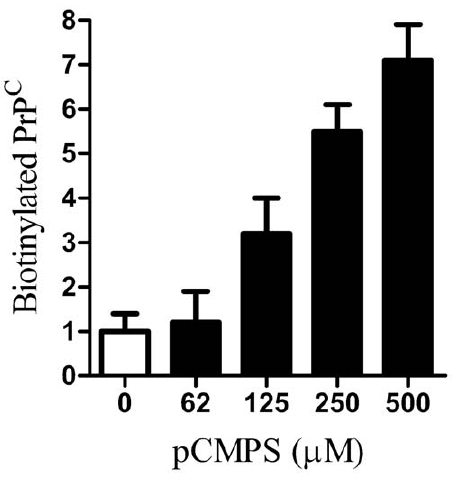
Figure 4. Glimepiride induced release of PrP C is reversed by p- CMPS. The amount of PrP C at the surface of cortical neurones treated for 1 hour with 5 m M glimepiride alone ( % ) or with combinations containing 5 m M glimepiride and different concentrations of p-CMPS as shown ( & ). Values shown are the mean average amount of biotinylated-PrP C (ng/10 6 cells) 6 SD, n=8.